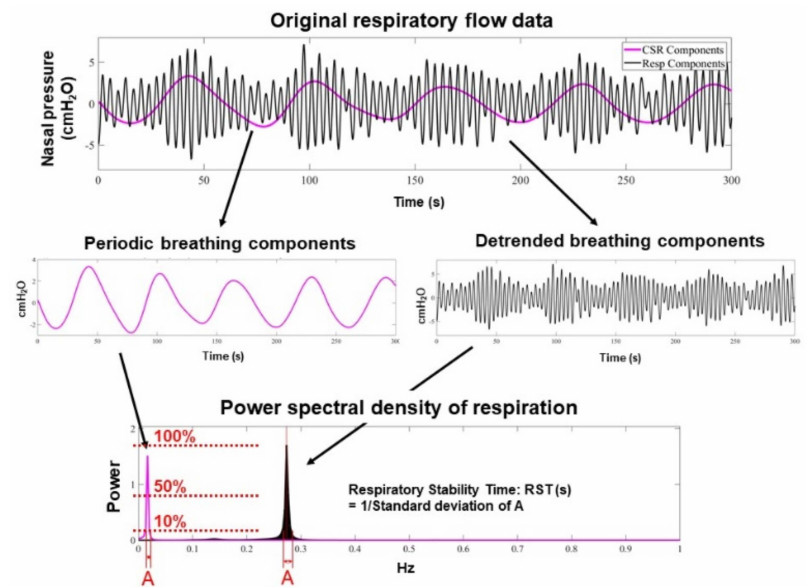
Figure 1. Methodology to calculate RST: All spectral power was normalized by the power spectral density or the ratio of the maximum power of the components. All respiration frequency points with a power spectral density > 10% were equally adopted in the assessment of respiratory instability. Very low frequency points of the periodic breathing curve were only adopted if the power spectral density of the very low frequency component was >50% of the maximum power of the respiratory component. Respiratory frequency points were evaluated using standard deviation, and RST was defined as the inverse of the standard